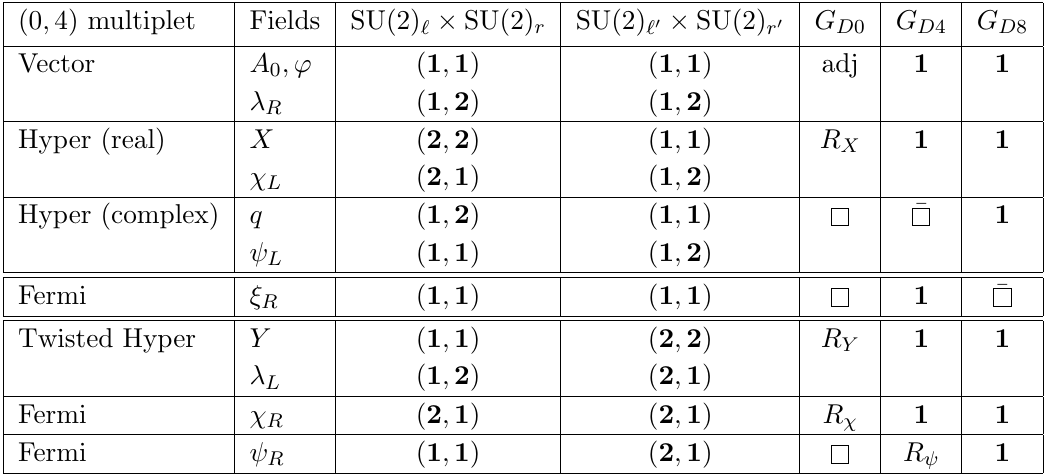
Table 1 . Spectrum of 1d N = (0 ; 4) gauge theory in a generic D0-D4-D8 system. The unspeci(cid:12)ed representations depend on the speci(cid:12)c model being considered. The subscript L; R refers to the spin of the corresponding